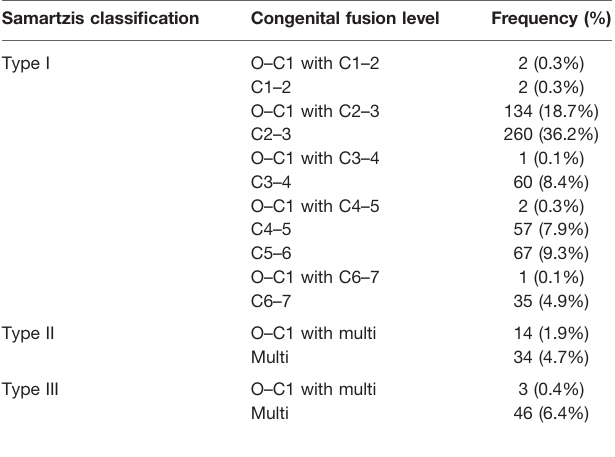
TABLE 5 | The distribution of various indications for surgery approaches.